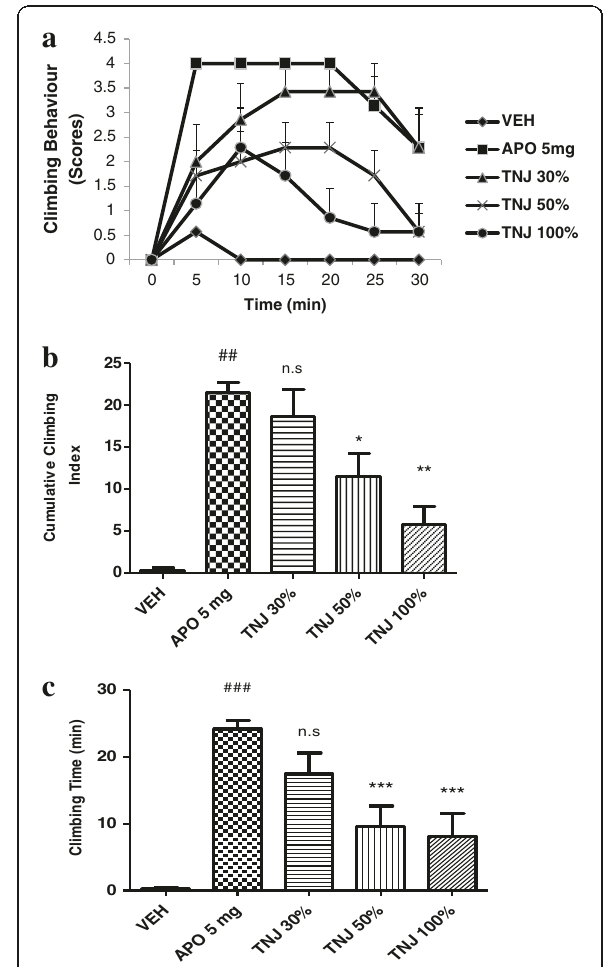
Figure 2 Effect of TNJ, (% v/v, 7 days in the drinking water) on cage climbing behaviour and climbing time induced by apomorphine in mice. ( a ) Each point represents the mean ± SEM from the scores obtained from seven animals. ( b ) The cumulative scores were measured for 30 min after administration of apomorphine. ( c ) Total time spent on the wall of the cage. ### p < 0.001, ## p < 0.01 compared with that of the saline group; * p< 0.05, ** p < 0.01, *** p <0.001 compared with that of the apomorphine (APO, mg/kg, i.p) group. n.s- not